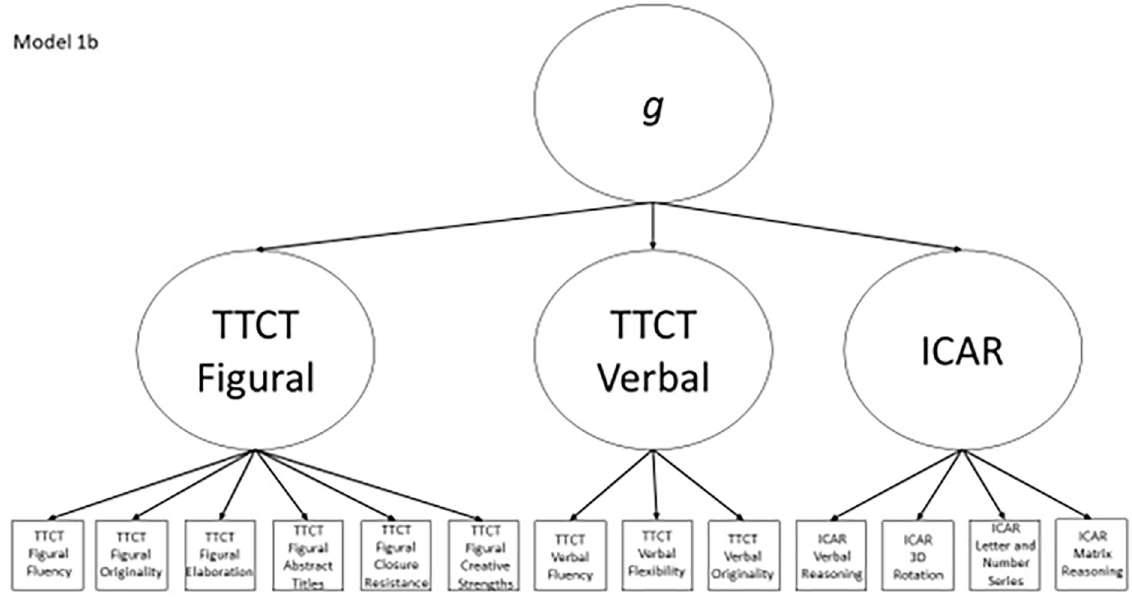
Fig 7. Confirmatory factor analysis diagram for model